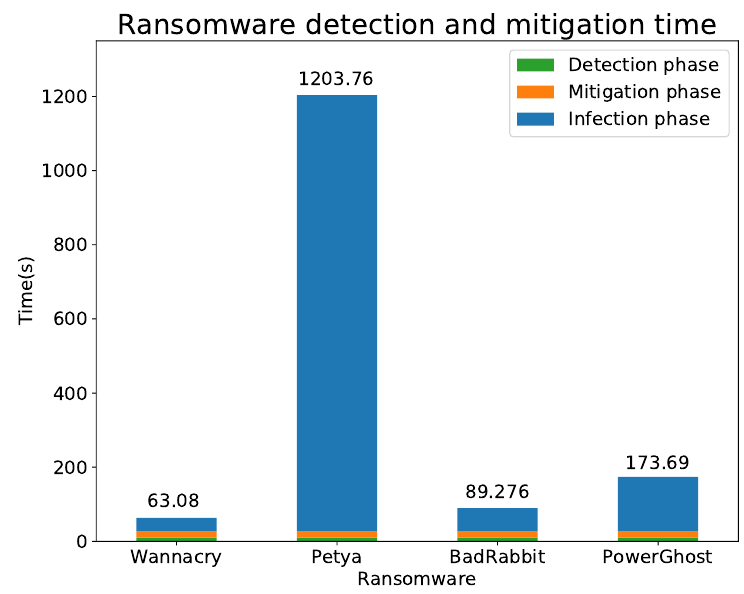
Figure 8. Comparison between the times required by the detection, mitigation and infection phases of ransomware. Detection and mitigation phases are running sequentially, whereas the infection phase goes in parallel to the previous